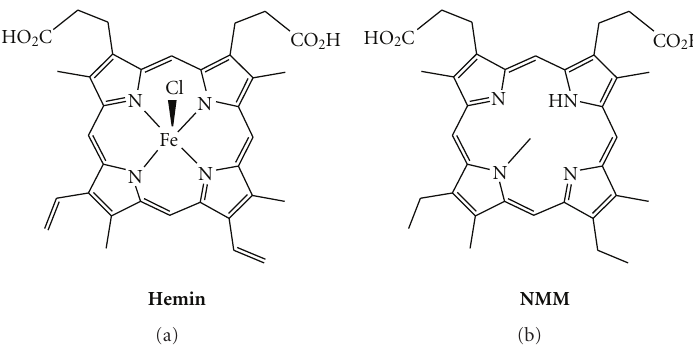
Figure 11: Chemical formulae of Hemin (a) and NMM (b).